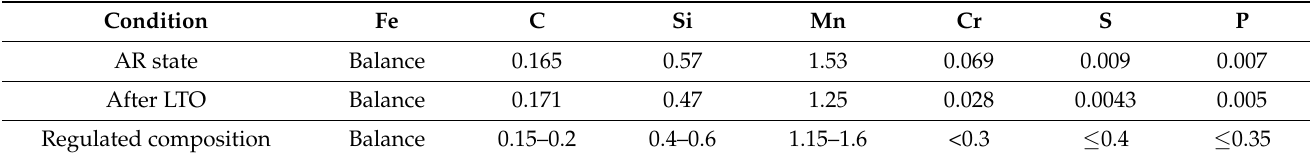
Table 1. Chemical composition of the investigated 17H1S steel (wt%).